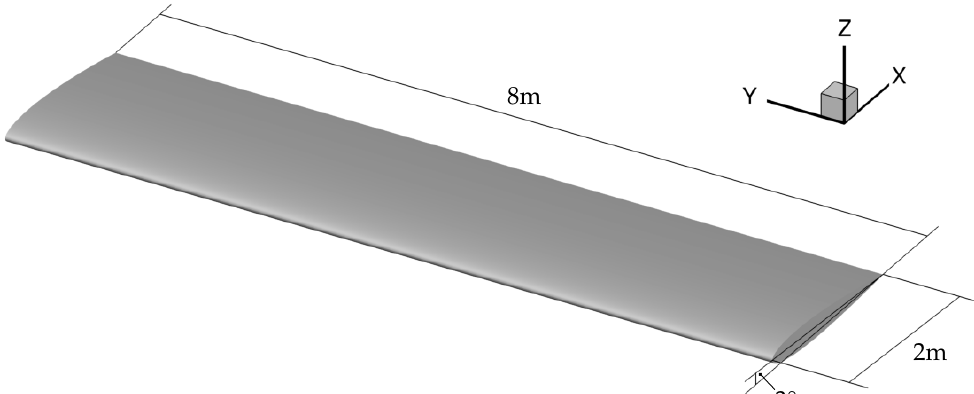
Figure 1. Geometry of the isolated HTP